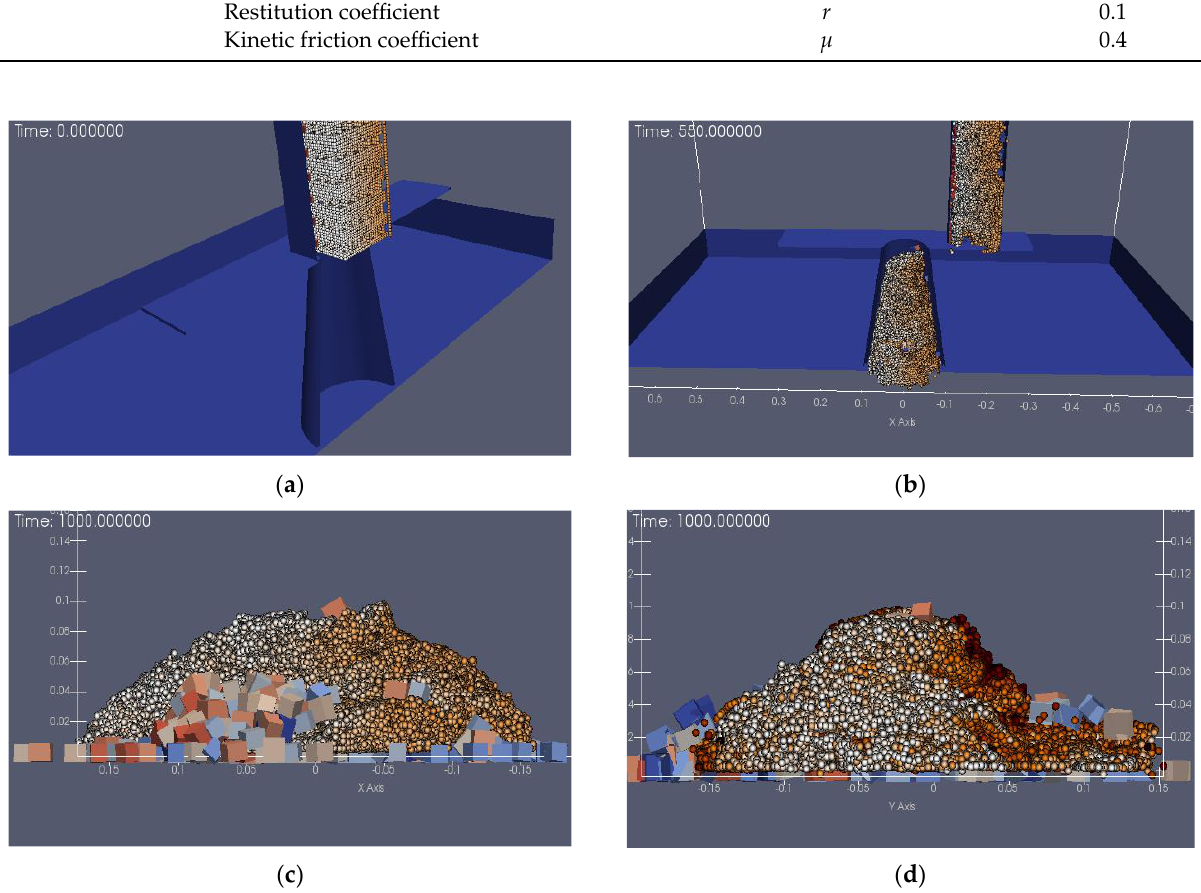
Figure 11. The slump numerical simulation of Group 1. ( a ) Initial state ( b ) lifting time ( c ) X-X Cross-sectional view ( d ) Y-Y Cross-sectional view Cross-sectional view ( d ) Y–Y Cross-sectional